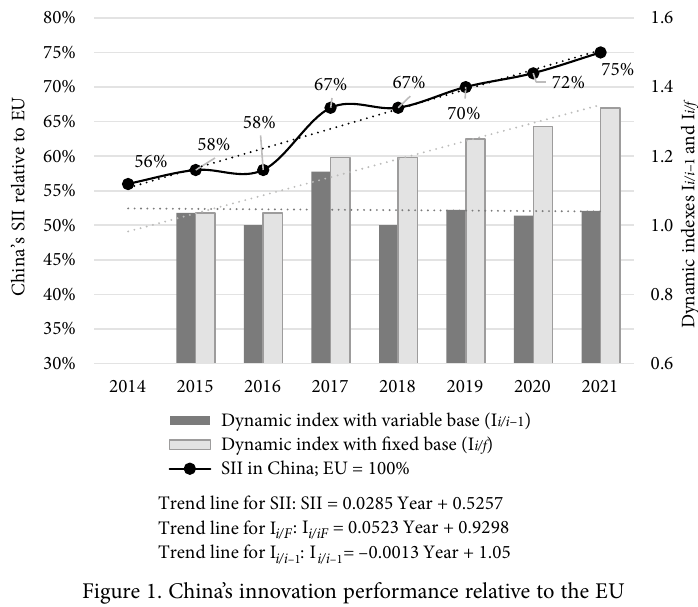
Figure 1. China’s innovation performance relative to the EU (source: author’s computations using data from the European Innovation Scoreboard 2021)